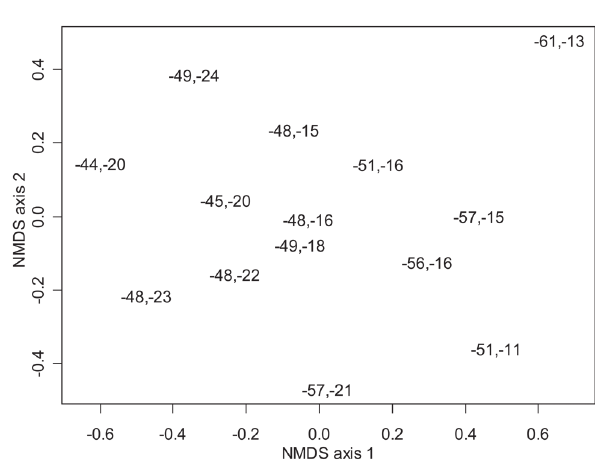
Figure 3. Non-Metric Multidimensional Scaling (NMDS) ordina- tion using the Simpson beta-diversity index of the 14 best-sampled cells. Cells are indicated by coordinates (longitude, latitude) of their left-hand inferior corner. Stress =